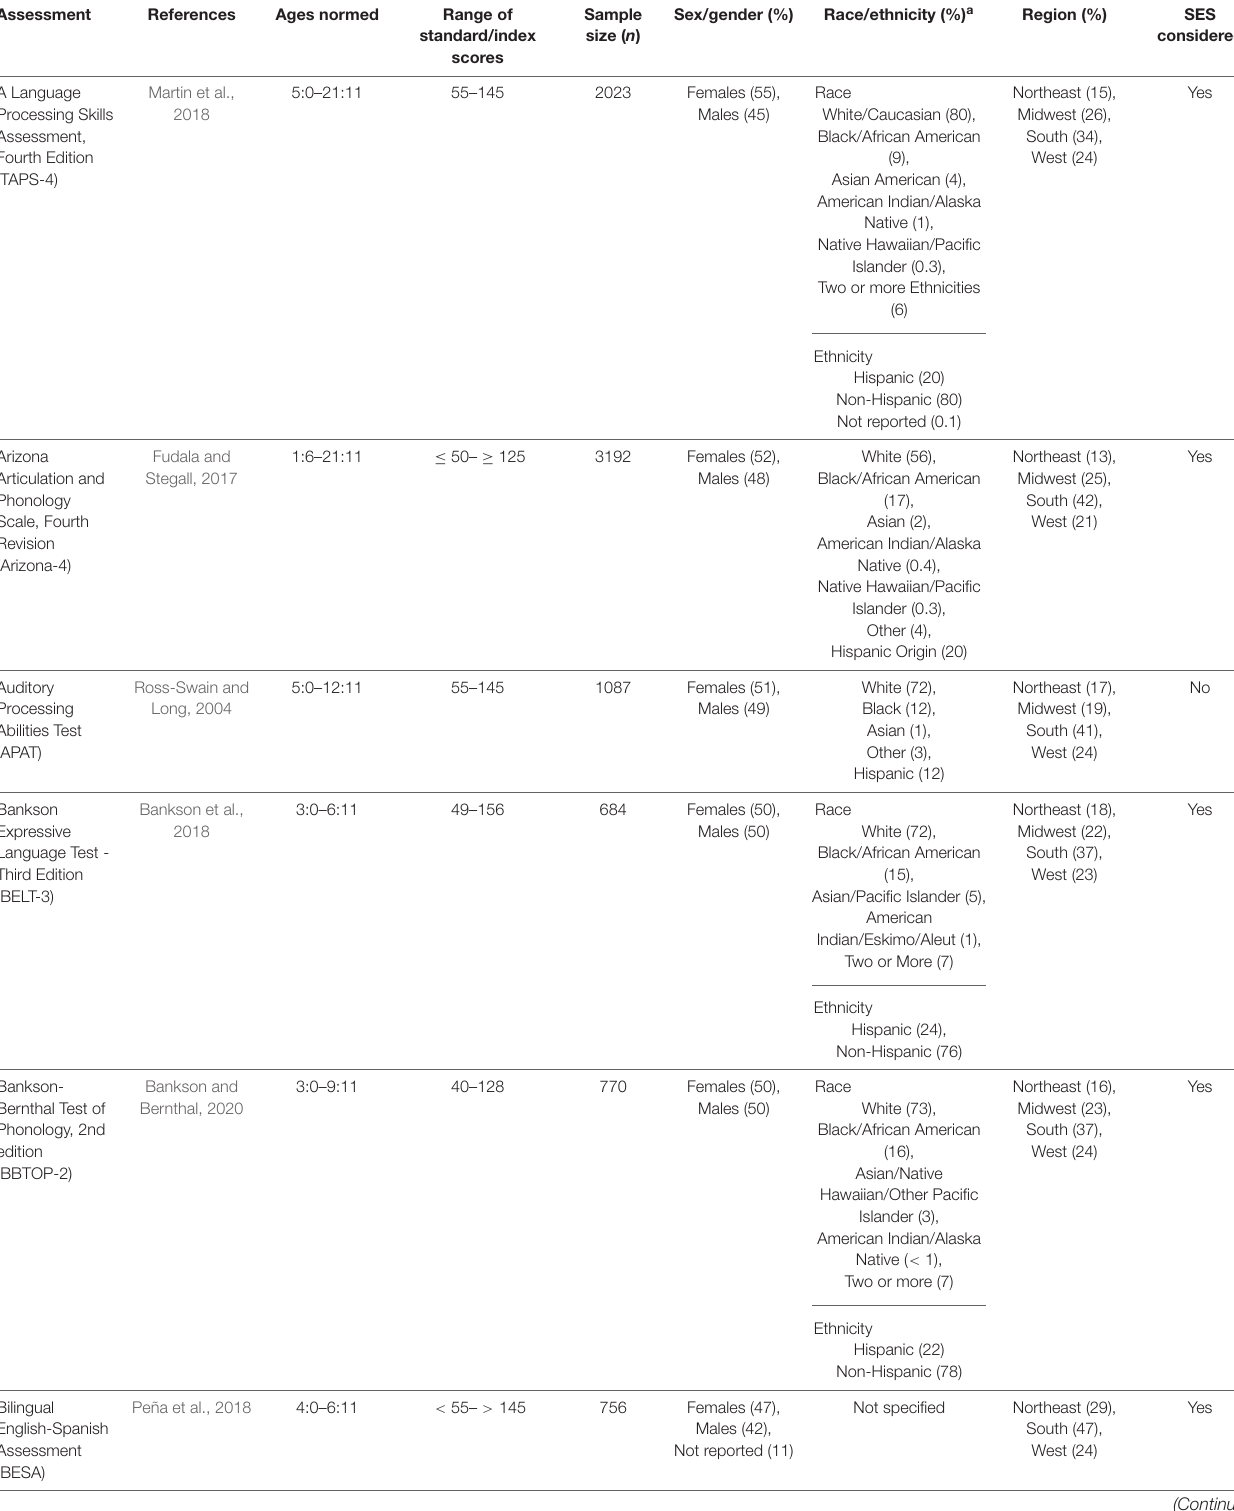
TABLE 1 | Normative samples in norm-referenced language